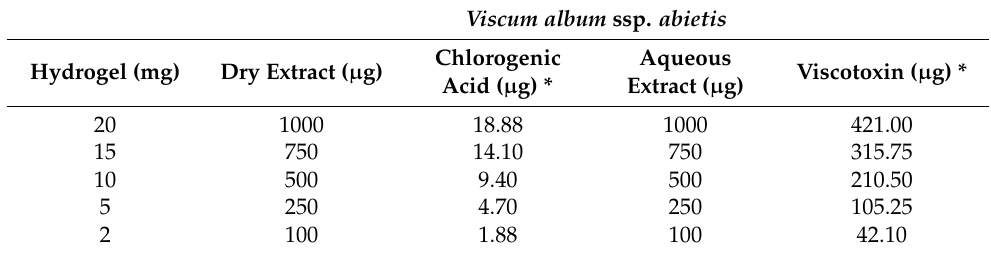
Table 5. Corresponding mass of hydrogel, extract, and chemical markers used in cytotoxicity assays. Viscum album ssp. abietis Hydrogel (mg)